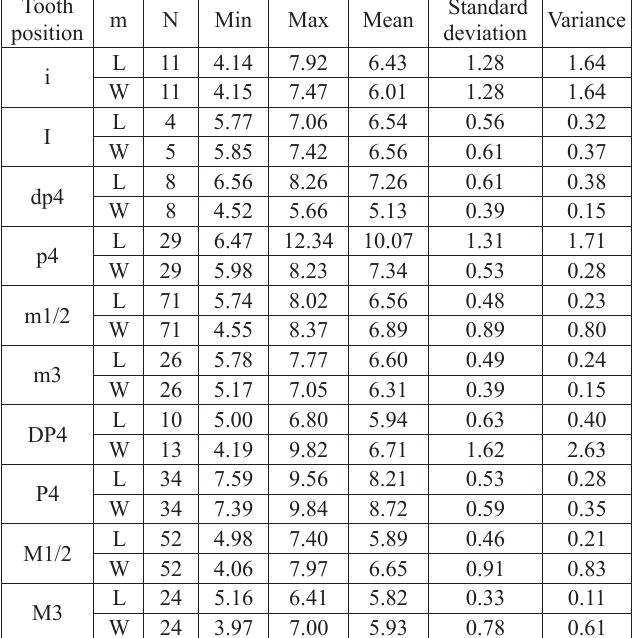
Table 1. Dimensions (in mm) of upper and lower teeth of the beaver Steneofiber depereti Mayet, 1908, from the lower Upper Miocene lo- cality of Hammerschmiede (Bavaria, Germany), with combined treat- ment of material from the local stratigraphic levels HAM 5 and HAM 4. L, mesio-distal length at occlusal surface and at basal position (where possible) for cheek teeth and length across anterior enamel band for incisors; W, bucco-lingual width at occlusal surface and at basal posi- tion (where possible) for cheek teeth; m, measurement; N, number of